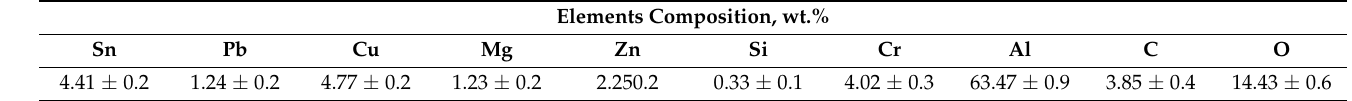
Table 5 below shows the chemical composition of SPS-ed Al–Cr alloy using the EDS technique. Table 5. Chemical composition of sintered Al–Cr alloy.